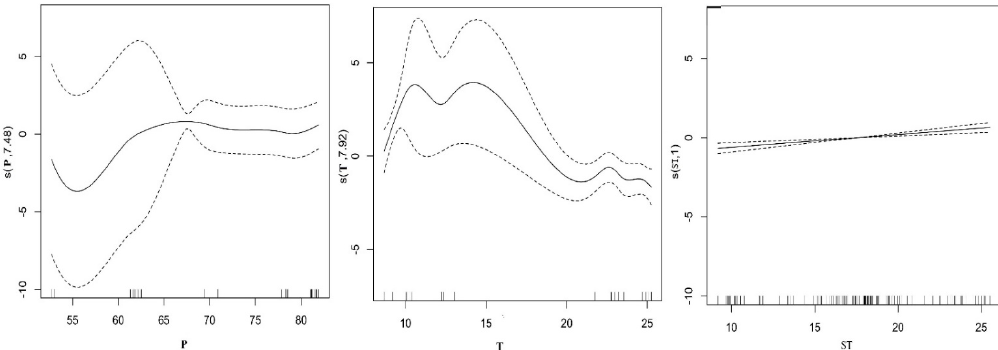
Figure 2. Response curves of carabid beetle and factors kept in the GAM analysis. The vertical axes are expressed in logits, and the value (s) represents the smoothing fitting value of explanatory variable of beetle species, the ordinate in parentheses is the estimated degrees of freedom. Solid curves are the function estimates, and dashed curves delimit the 95% confidence intervals for each function.